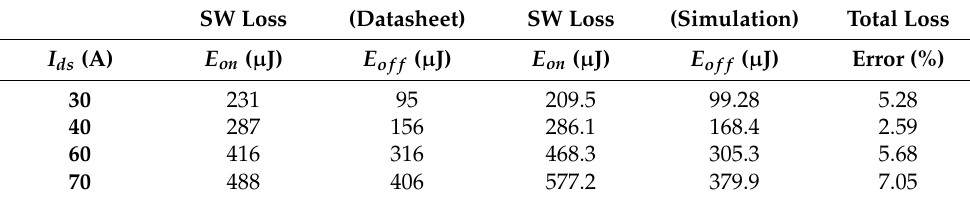
Table 5. SiC MOSFET SW loss comparison table at 25 ◦ C.